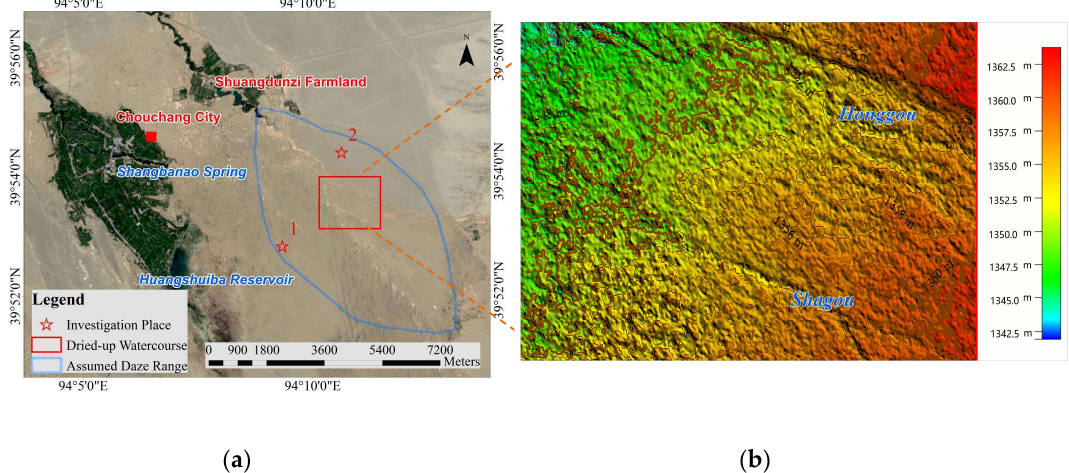
Figure 8. Upstream dried-up watercourses of the Shagou and Honggou located in the assumed range of the Daze during the Tang Dynasty. ( a ) Location of the dried-up watercourses on the Landsat 8 OLI image; ( b ) shaded relief model of the dried-up watercourses Shagou and Honggou. Two sample locations were investigated during the fieldwork. One is located in Gobi in an area with few or no arid land vegetation, and the other is located in the Yangguan National Natural Reserve, where arid land vegetation is present, as shown in Figure 8a. Interestingly, at both sample locations, the soil profiles exhibit cross-sectional layers shaped like the letter “V” approximately 20 cm below the surface, as shown in Figure 9a,b; these features are assumed to be spring vents. This finding indicates that many springs were distributed in the range of the largest ancient wetland in the Nanhu region [1].